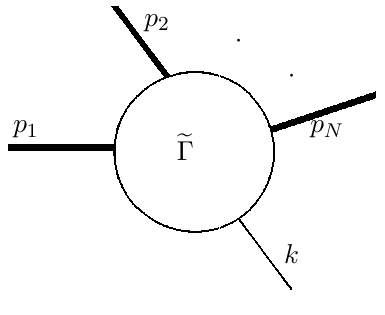
Figure 2 . Source of the subleading contribution to the amplitude with one external soft graviton. Here e (cid:0) denotes tree amplitudes with external propagators removed, and also diagrams of the type given in (cid:12)gure 1, where the soft graviton attaches to one of the external (cid:12)nite energy lines, removed.